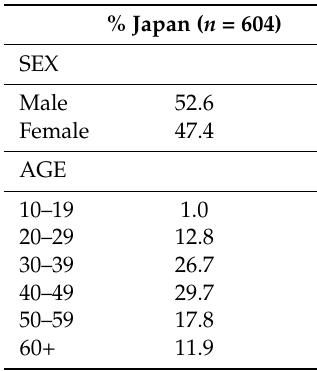
Table 2. Summary of the CE survey.